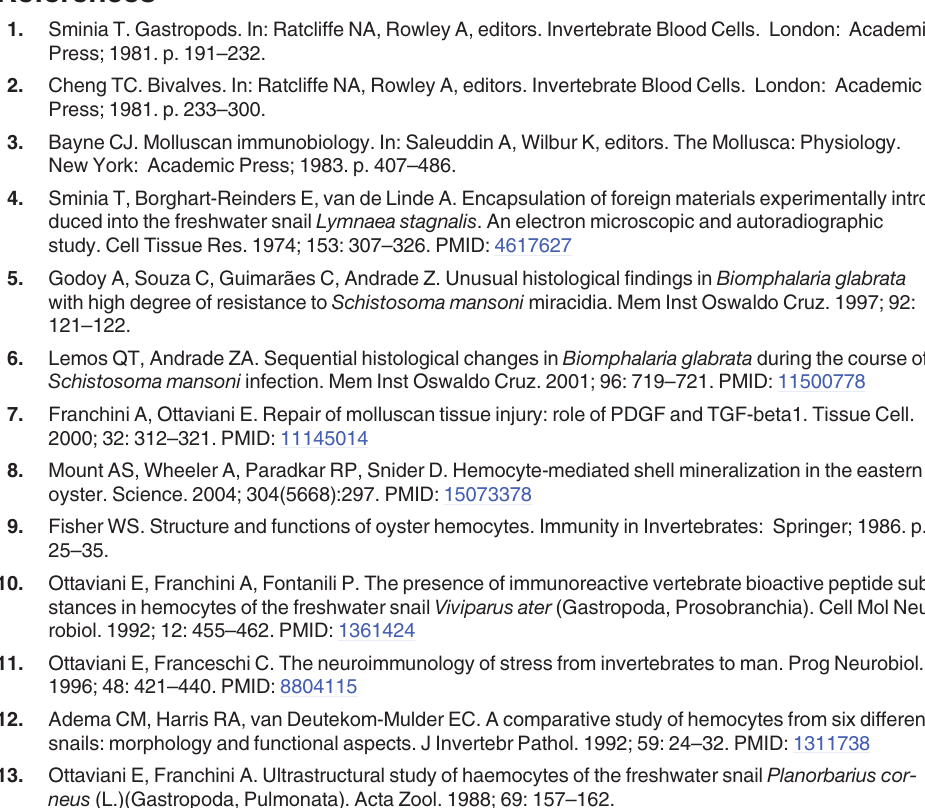
S1 Fig. Obtention of dispersed hemocytes from collagenase-treated kidney tissue. (A) Dot plot of cell size vs . complexity-granularity of dispersed cells and urinary concretions after colla- genase digestion. (B) Dot plot of cell size vs . fluorescence emission (Comp-PI-A); the framed region was sorted and used to test for phagocytic activity. (C) Dot plot of cell size vs . complexi- ty-granularity of cells contained within the region framed in B; which were predominantly he- mocytes (phase contrast microscopy, not shown in the figure).